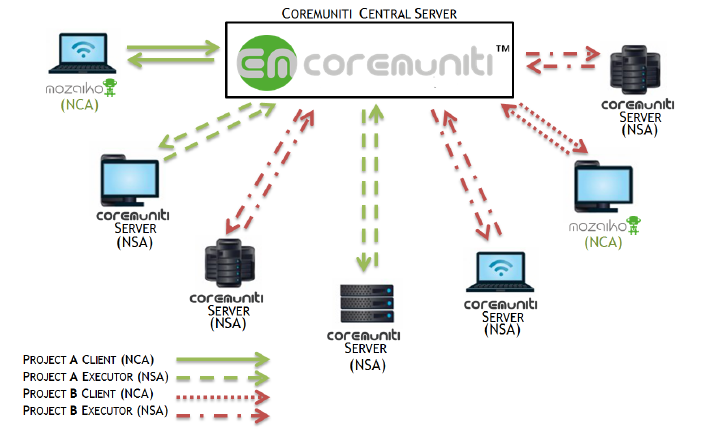
Figure 1. Coremuniti system at